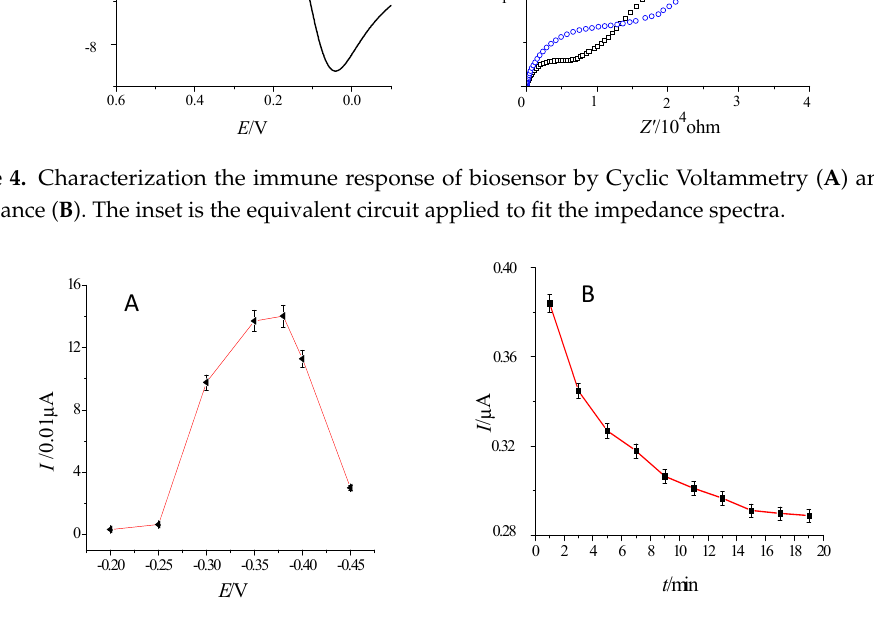
Figure 5. Optimization of detect potential ( A ) and incubation time ( B ).